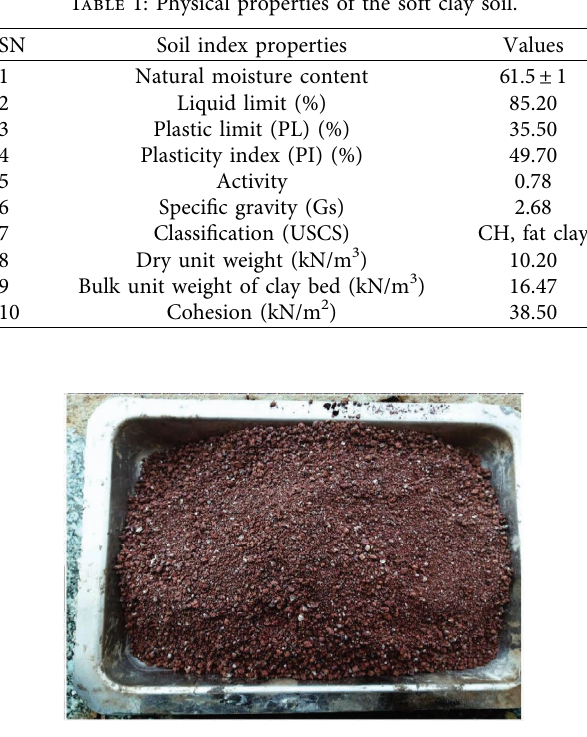
Figure 1: Sample of cinder gravel used for the experimental model.